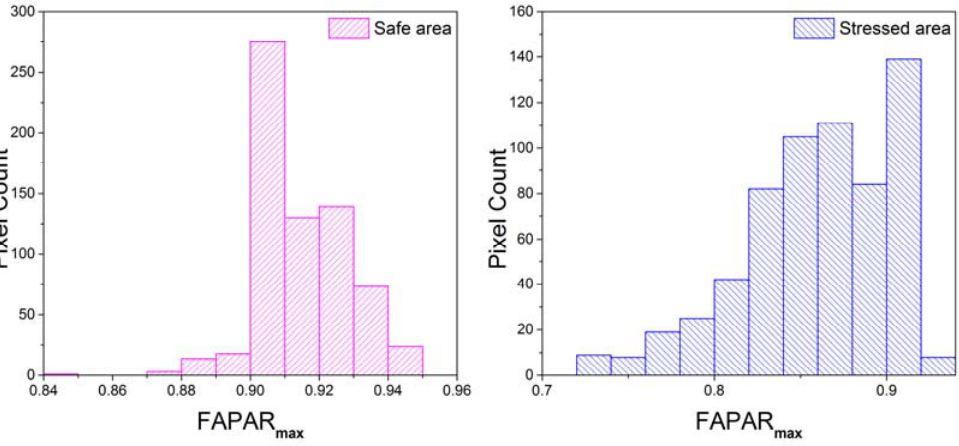
Figure 7. Frequency distribution of FAPAR max in the two areas. All pixels covered with rice are extracted by visual interpretation and supervised classification.